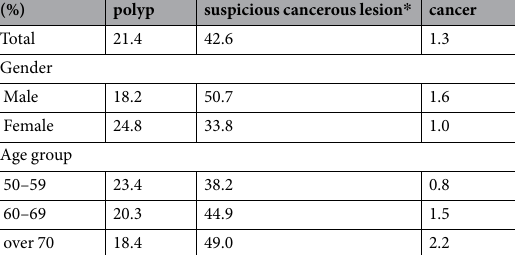
Table 2. Predictive value of positive test of fecal occult blood test according to colonoscopy or double-contrast barium enema results. * Suspicious cancer lesions were categorized in the database based on individual physicians’ descriptions to express wide spectrum between definitive polyp and definitive cancer, possibly including inflammatory or high-grade dysplastic lesions that required further biopsy